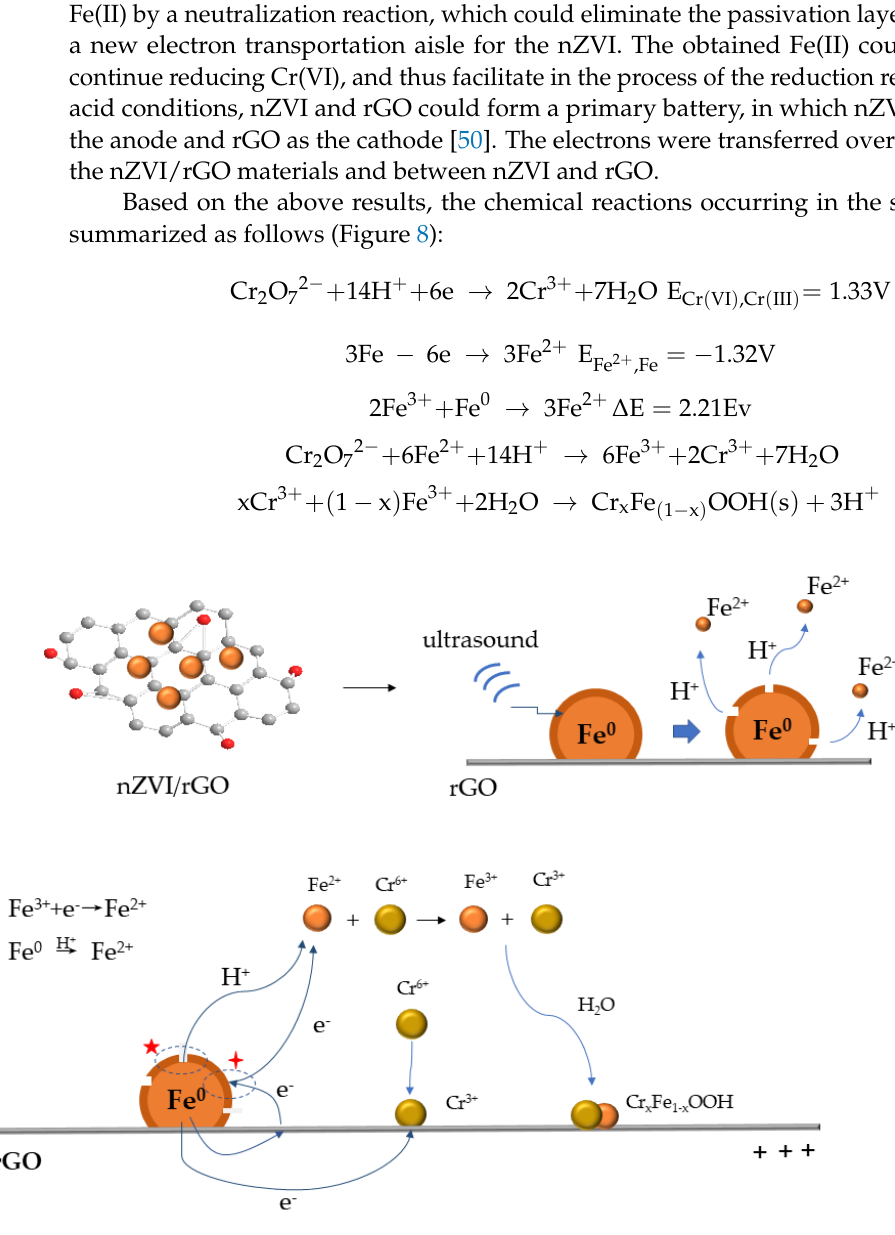
Figure 8. Mechanism of the sequestration of Cr(VI) on nZVI/rGO coupled with ultrasonic pretreatment.